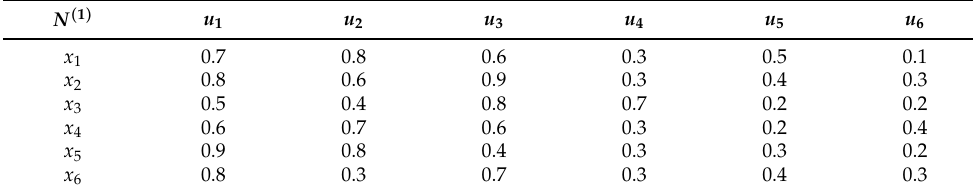
Table 6. Normalized decision matrix of expert e 1 .